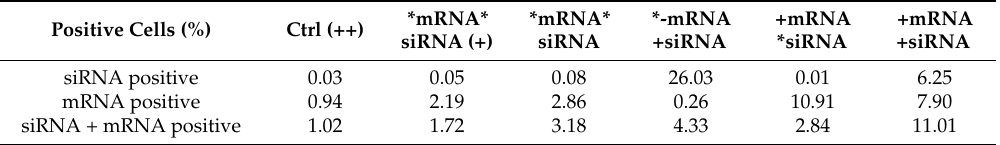
Table 1. Transfection efficiency values of co-transfection with eGFPmRNA and siRNA AF 555. (++): without Lipofectamine ® 2000 and PLGA 1; (+): without Lipofectamine ® 2000; *: without; + with. Ctrl =